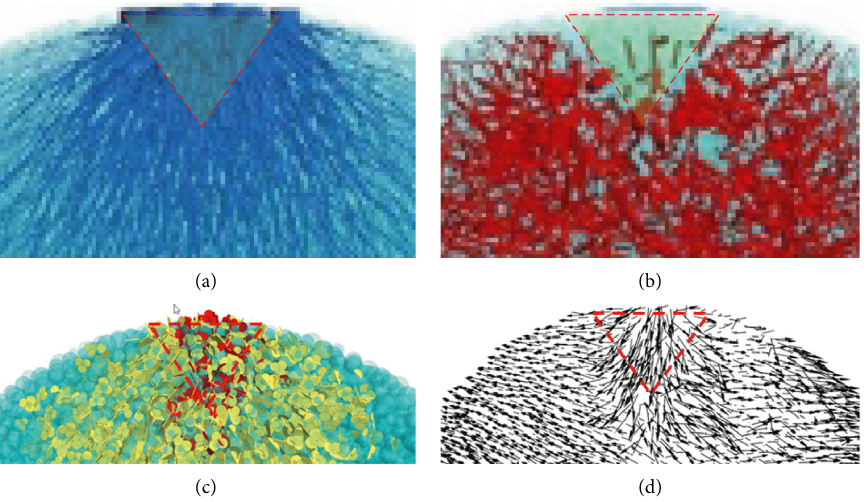
Figure 14: Cone core of numerical simulation sample: (a) compression chain, (b) tension chain, (c) bonded fracture, and (d) velocity